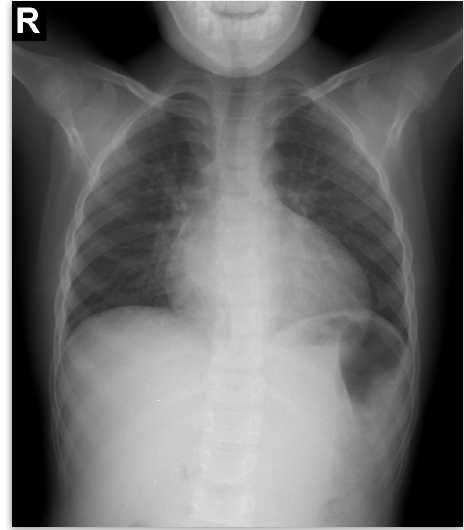
Figure 7. Chest X-ray.